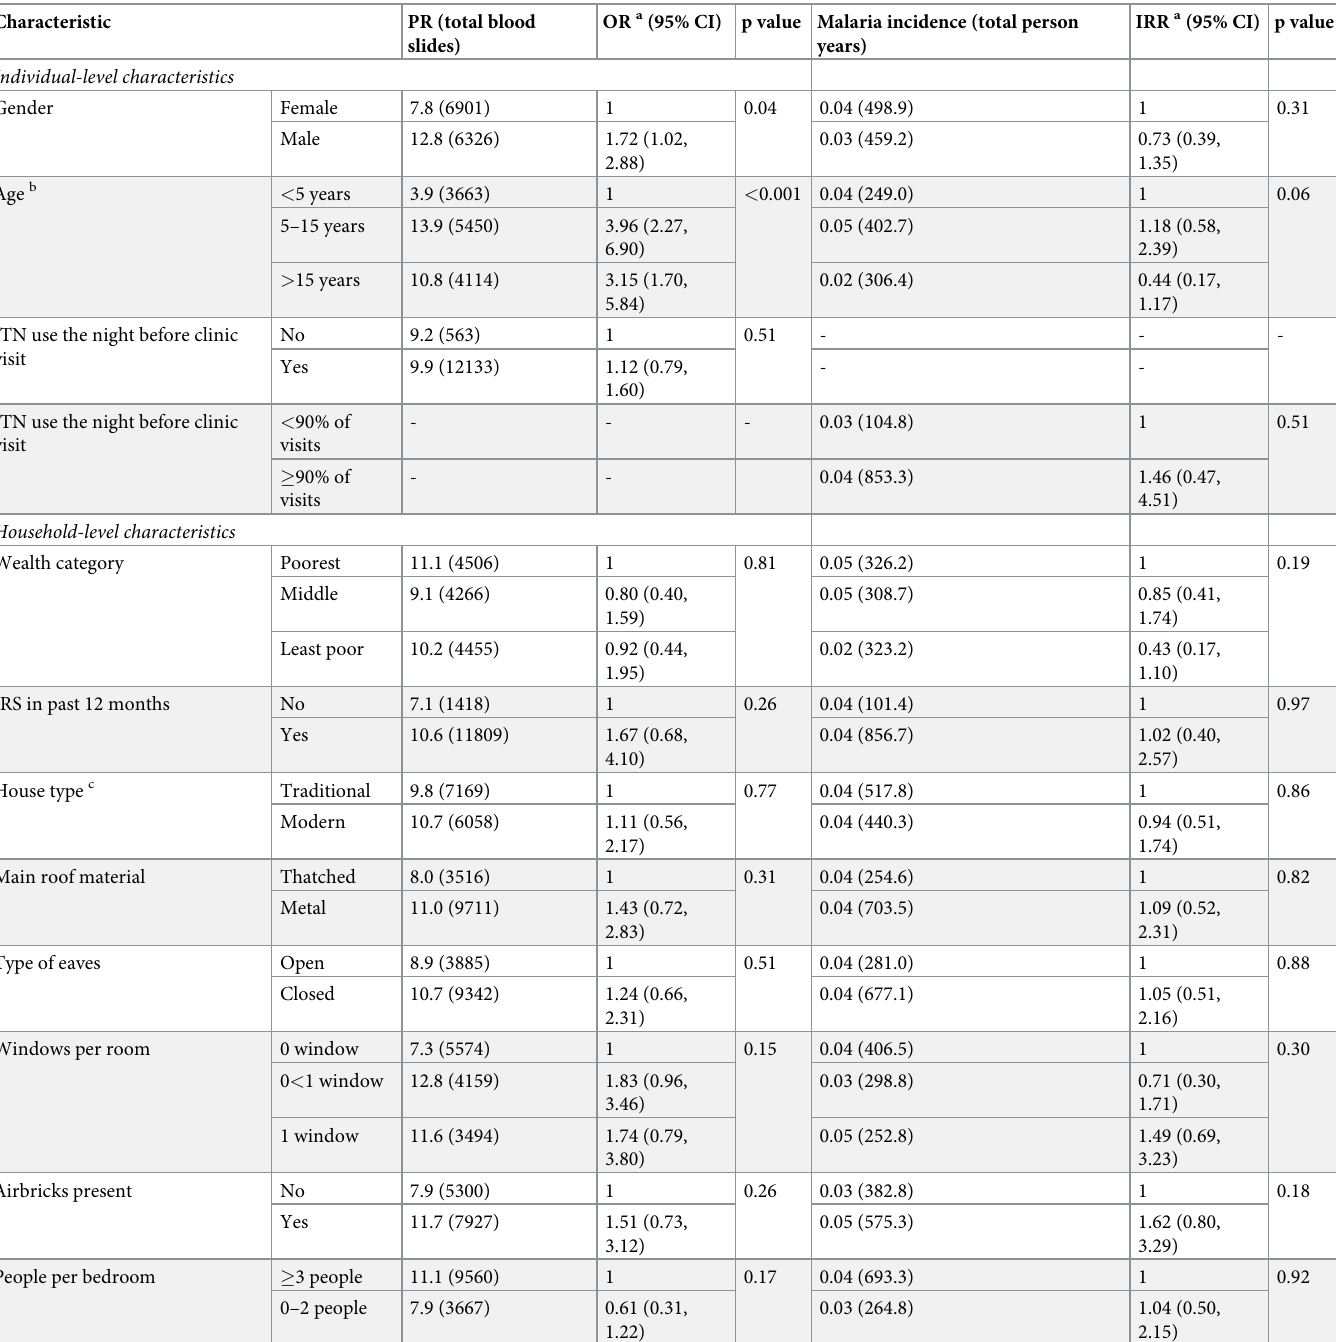
Table 3. Association between house type and malaria in Nagongera, Uganda (adjusted results).